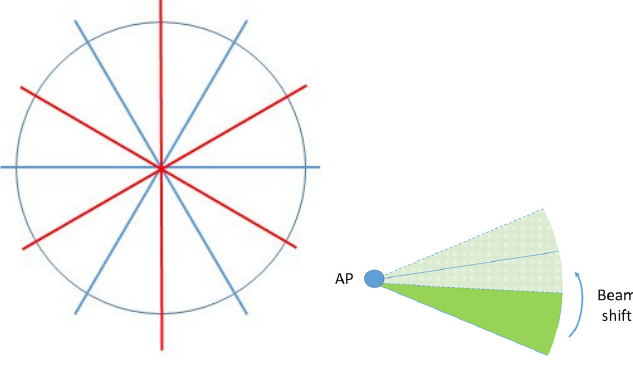
Figure 3. Shifting of sectors strategy.